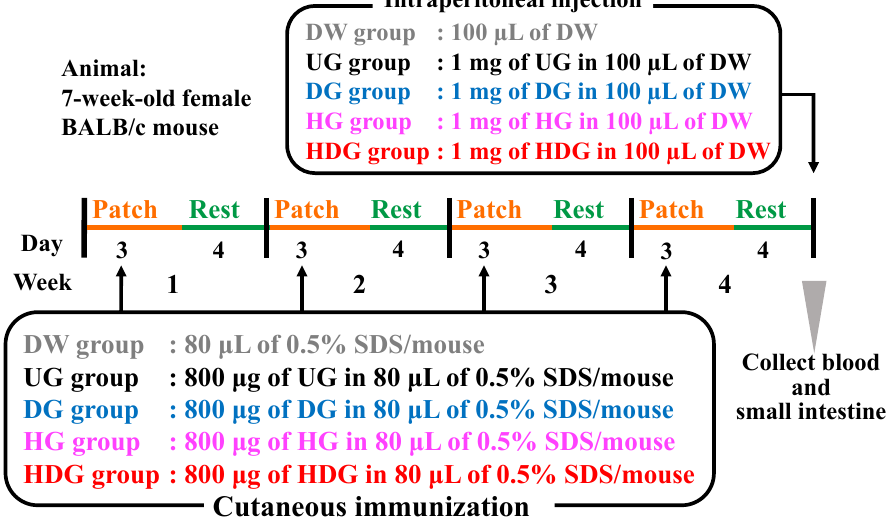
Figure 1. Experimental design to evaluate allergenicity and cutaneous sensitivity of each gliadin (n = 8).